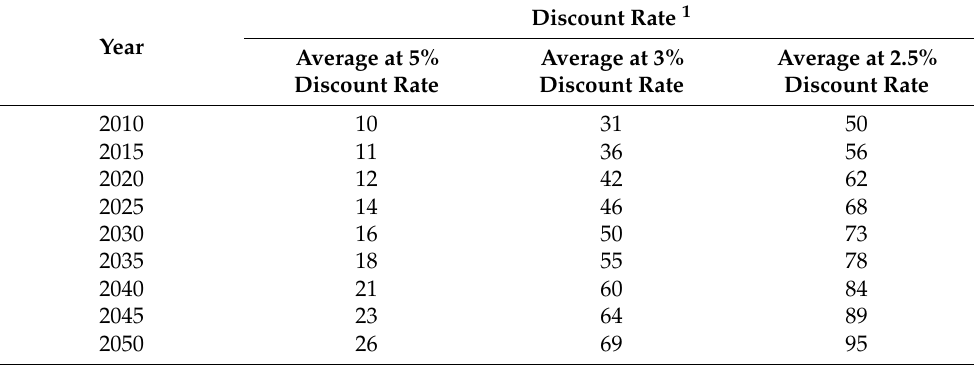
Table 2. Estimated social cost of carbon (SCC) values under different discount rates for different years by the United States Environmental Protection Agency (US EPA).